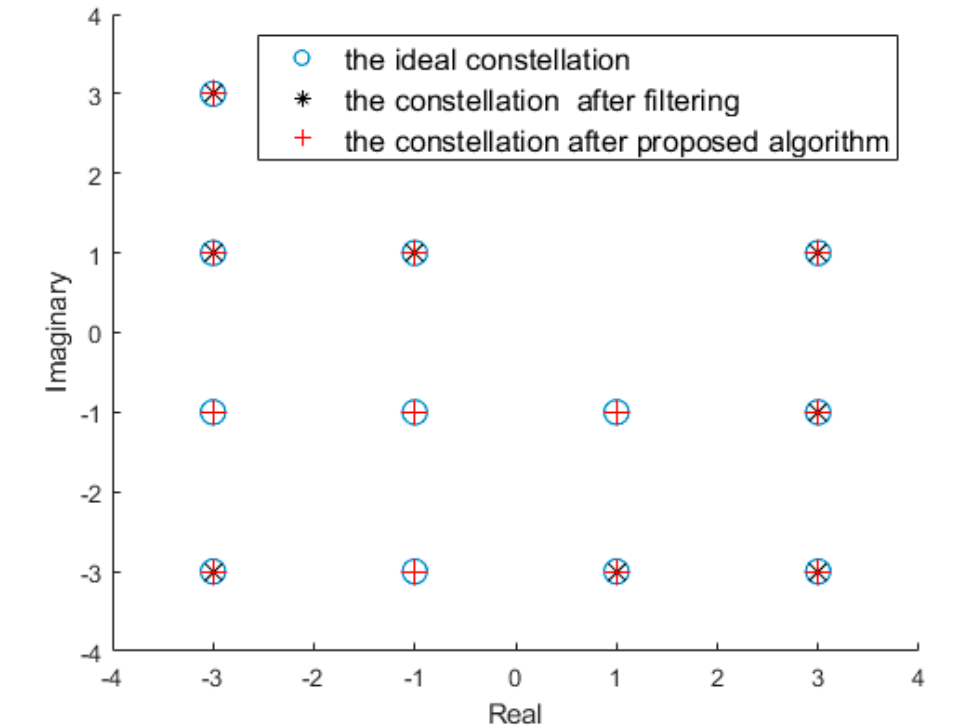
Figure 9. The results of the constellations of the ideal, proposed algorithm and fi ltering (strong